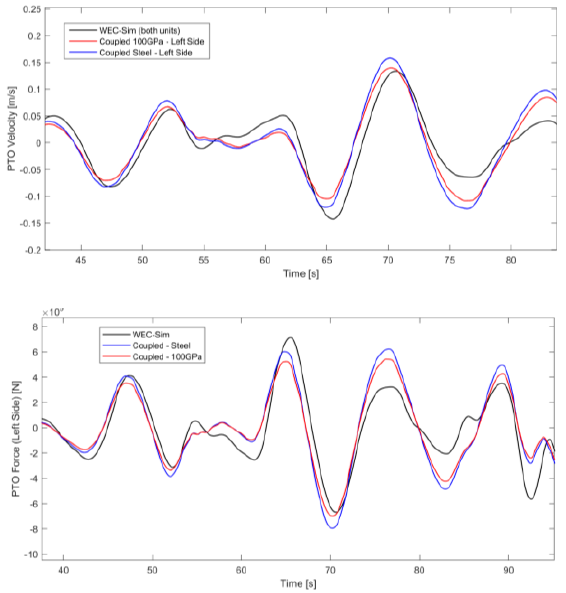
Fig. 15. Time-series of PTO velocity (top) and force (bottom) for different material stiffnesses – WEC-Sim rigid-body solution (black), coupled analysis with steel (blue) and coupled analysis with flexible material (red)